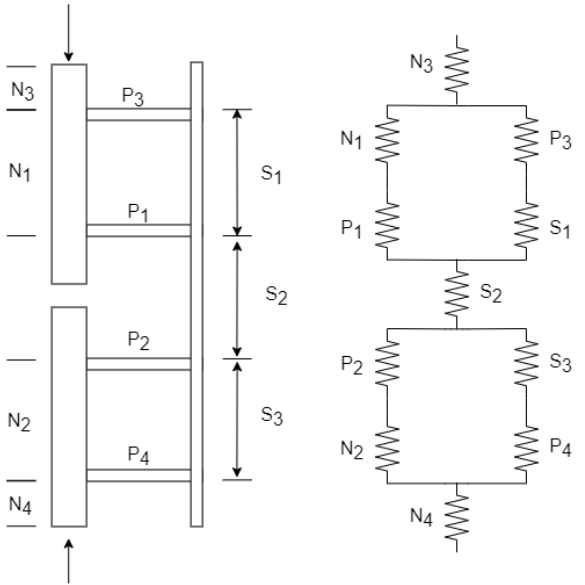
Figure 11. Simplified system. Spring constants of each segment calculated based on their material properties and type of deformation. N-Bone analogous, P-Pin, and S-Shaft.